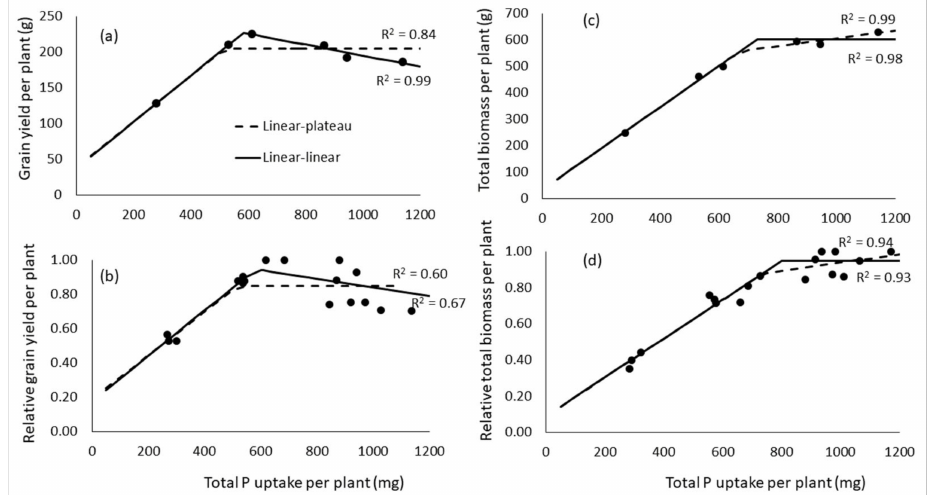
Figure 5. Breakpoint analysis by linear-plateau and linear-linear modelling of the relationship between total phosphorus (P) uptake and grain yield ( a , b ) and total biomass ( c , d ), presented for values averaged across hybrid ( a , c ) and relative values for each hybrid ( b , d ). Breakpoints and associated p -values that describe how well each model fit the data are listed in Table 2. Plots ( b , d ) (relative yield and biomass) have more data points than ( a , c ) because it is not valid to average relative values across different hybrids. Table 2. Total phosphorus (P) uptake breakpoints indicating a significant change in slope for the relationships between total P uptake and grain yield and total biomass shown in Figure 5. Data fit to both linear-plateau and linear-linear models for yield and total biomass averaged across hybrids; relative yield and total biomass were not averaged across